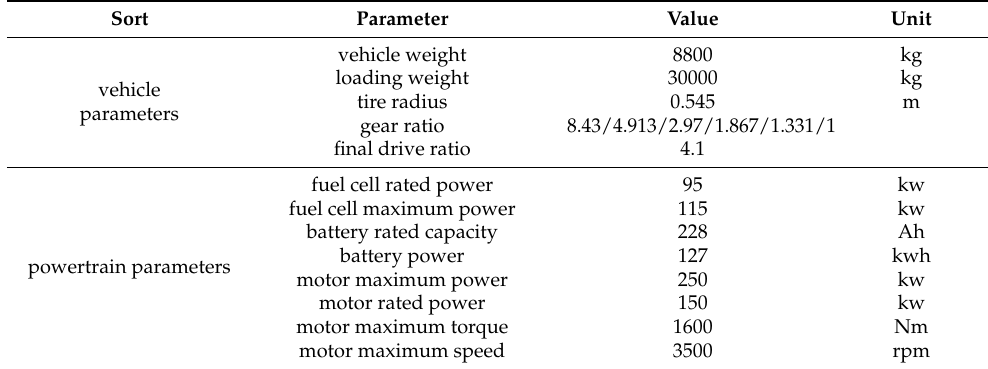
Figure 1. Schematic of the FCHV configuration. Table 1. Vehicle parameters.